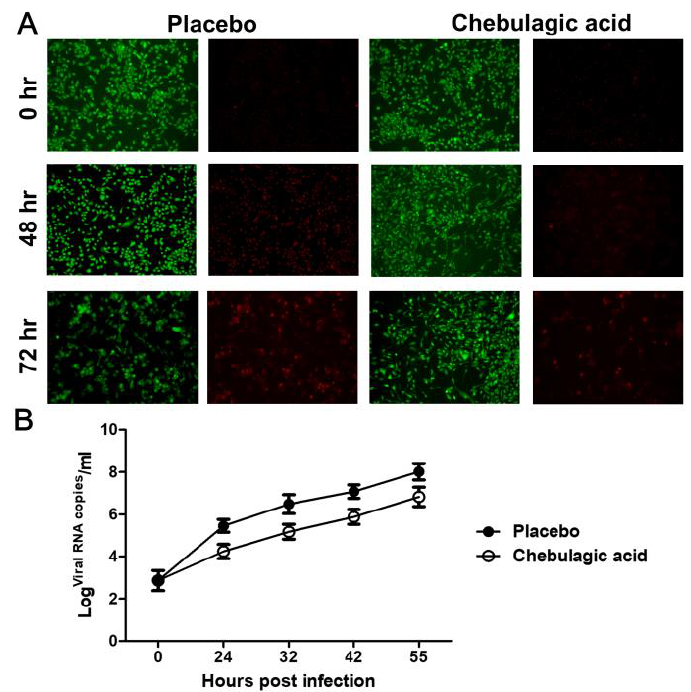
Figure 2. Effect of chebulagic acid on enterovirus 71 (EV71) replication in rhabdomyosarcoma (RD) cells. ( A ) The infected RD cells were treated with chebulagic acid or saline at 2 h post EV71 infection, and then the cytopathic effect (CPE) of the RD cells was observed after AO/EB double staining under a light microscope (100 × ) at 0 h, 48 h and 72 h post infection, respectively. ( B ) The viral RNA copies in the culture supernatant of the RD cells were detected by quantitative RT-PCR (qRT-PCR). The data are expressed as the mean values of three independent experiments. The authors apologize for any inconvenience caused and state that the scientific